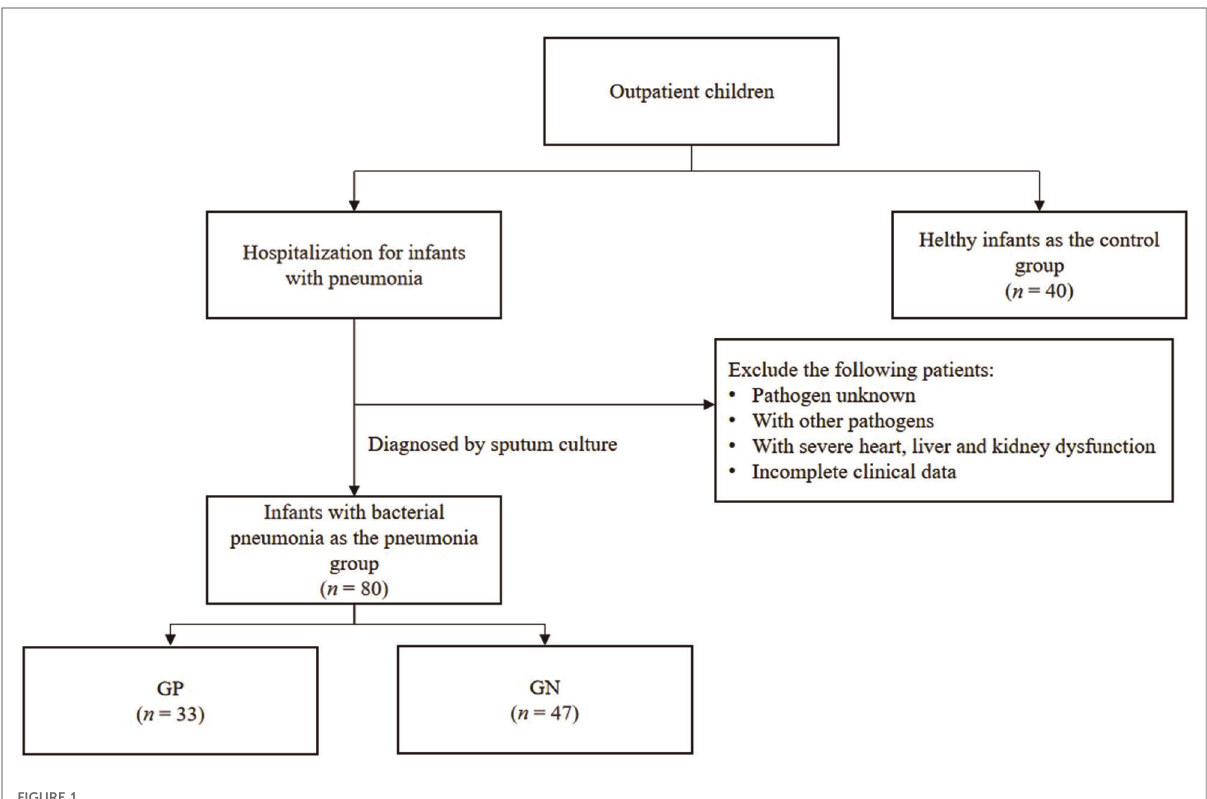
FIGURE 1 Follow diagram of subject selection ( n :